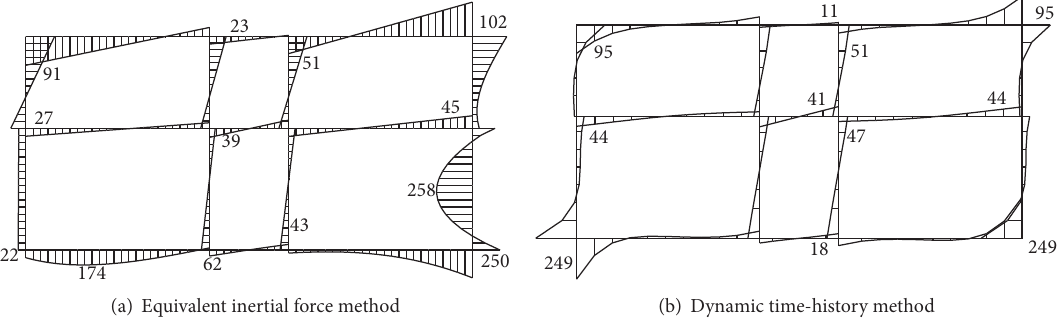
Figure 8: The moment diagram of the maximum dynamic internal force of two layers and three crosses station structure (kN ⋅ m).